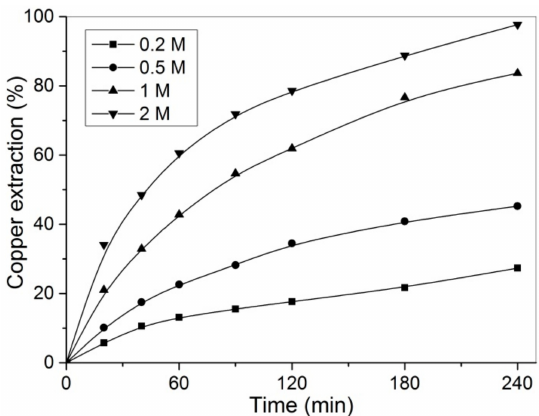
Figure 6. Influence of H 2 O 2 concentration on the copper extraction yield (temperature—40 ◦ C,